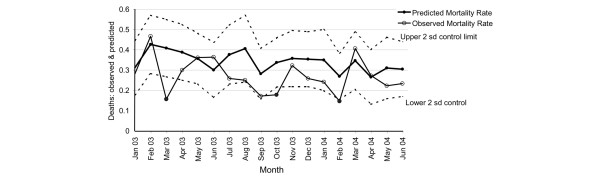
Risk-adjusted p Chart by month. Probability of death estimated with UK APACHE, Royal Berkshire Hospital, 1 January 2003 to 30 June 2004.